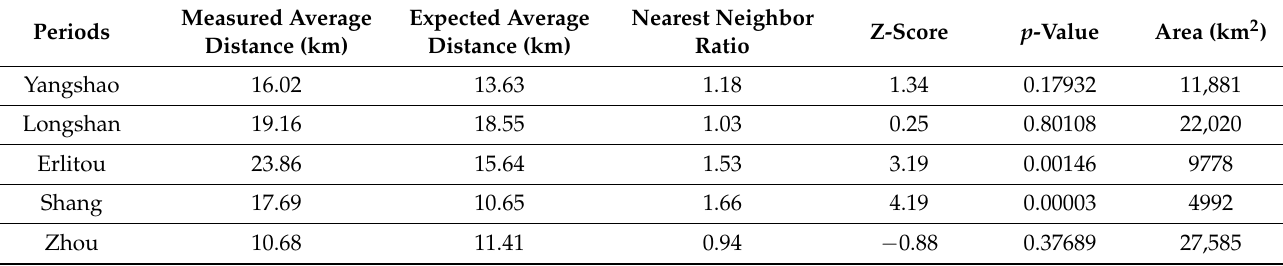
Figure 4. Results of ANN analysis. ( a ) Yangshao Culture. Given the z-score of 1.34, the pattern does not appear to be statistically significantly different from a random distribution; ( b ) Longshan Culture. Given the z-score of 0.25, the pattern does not appear to be statistically significantly different from a random distribution; ( c ) Erlitou Culture. Given the z-score of 3.18, there is a less than 1% likelihood that this dispersed pattern could be a result of randomness; ( d ) Shang Dynasty. Given the z-score of 4.19, there is a less than 1% likelihood that this dispersed pattern could be a result of randomness; ( e ) Zhou Dynasty. Given the z-score of − 0.88, the pattern does not appear to be statistically signifi- cantly different from a random distribution. Table 3. Results of average nearest neighbor